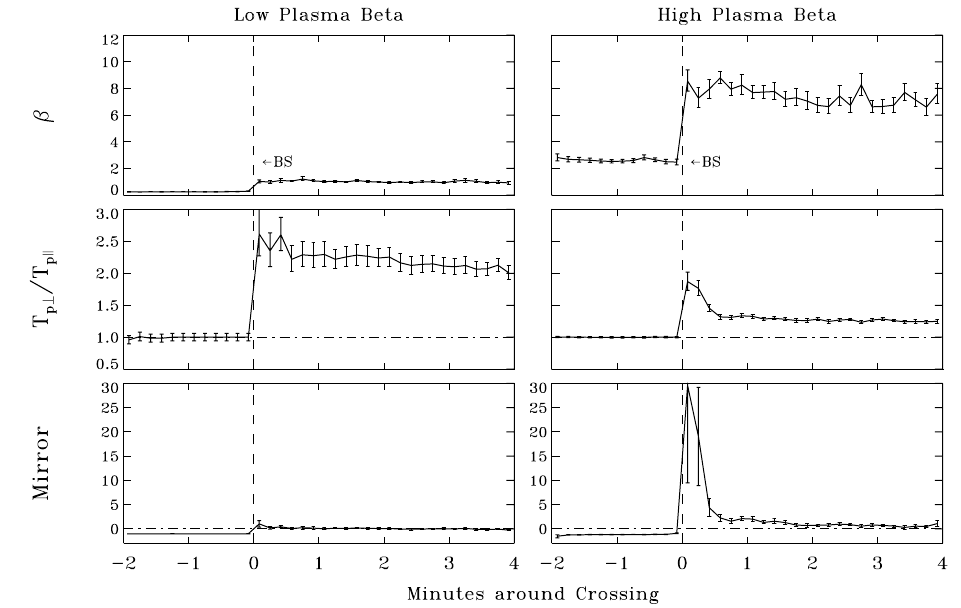
Fig. 4. Superposed-epoch analysis of the plasma parameter β , the proton temperature anisotropy T p ⊥ /T p k , and the mirror instability criterion from 2min upstream to 4 min downstream of the quasi-perpendicular bow shock (BS) on the left for 20 low- β , on the right of 47 high- β